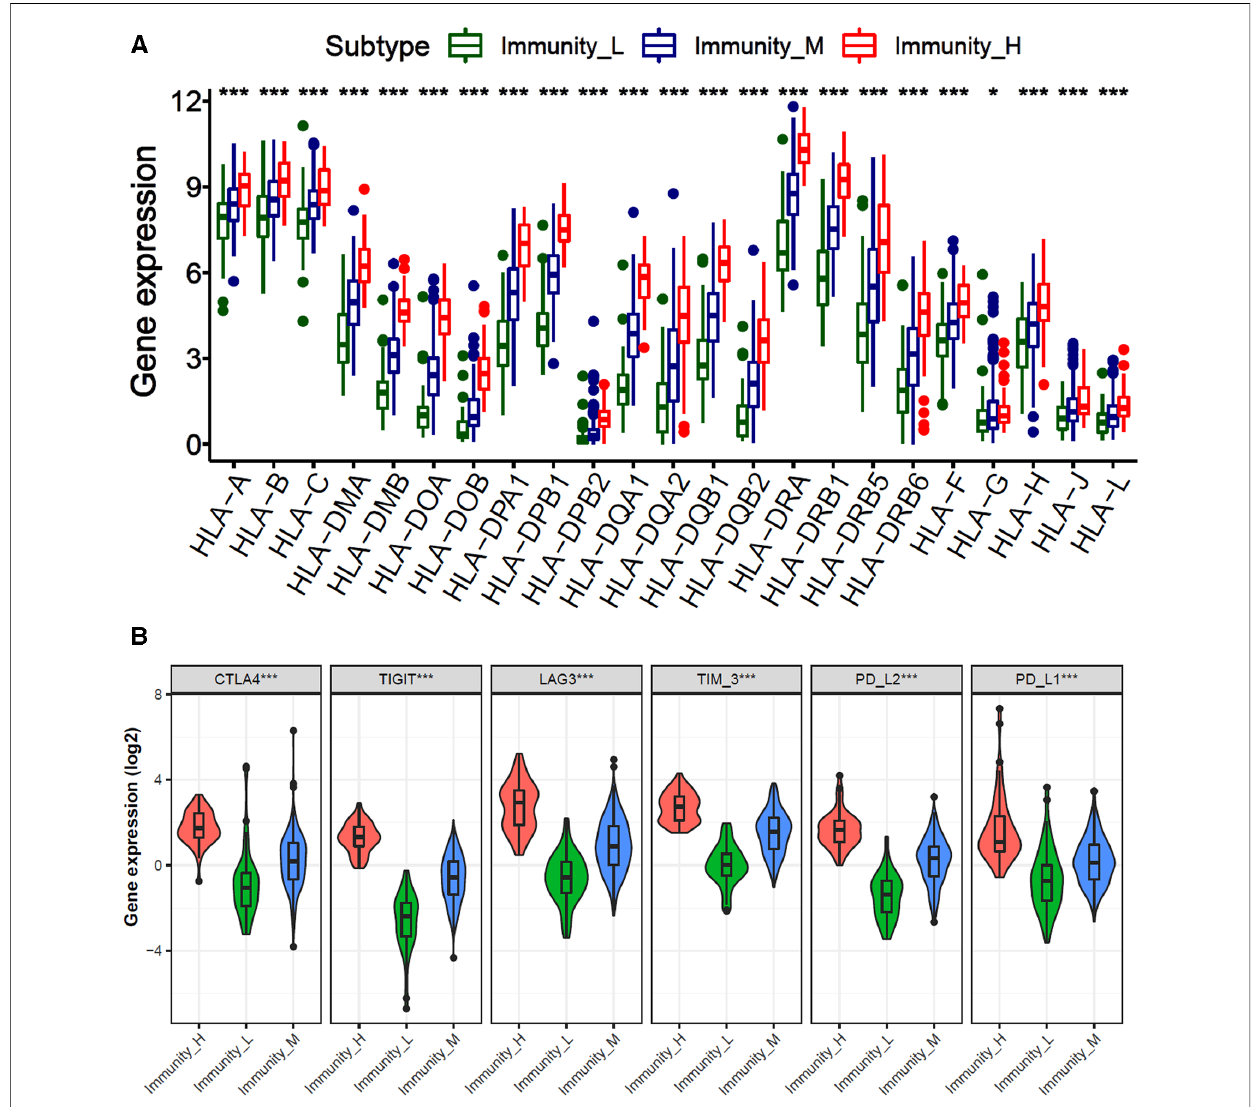
FIGURE 2 Comparison of HLA and immune checkpoint-related gene expression among three immune subtypes. ( A ) The bar plot of HLA-related genes expression among immunity-H, -M and -L subtypes in gastric cancer. ( B ) Violin diagram of immune checkpoint genes expression in immunity-H, -M and -L